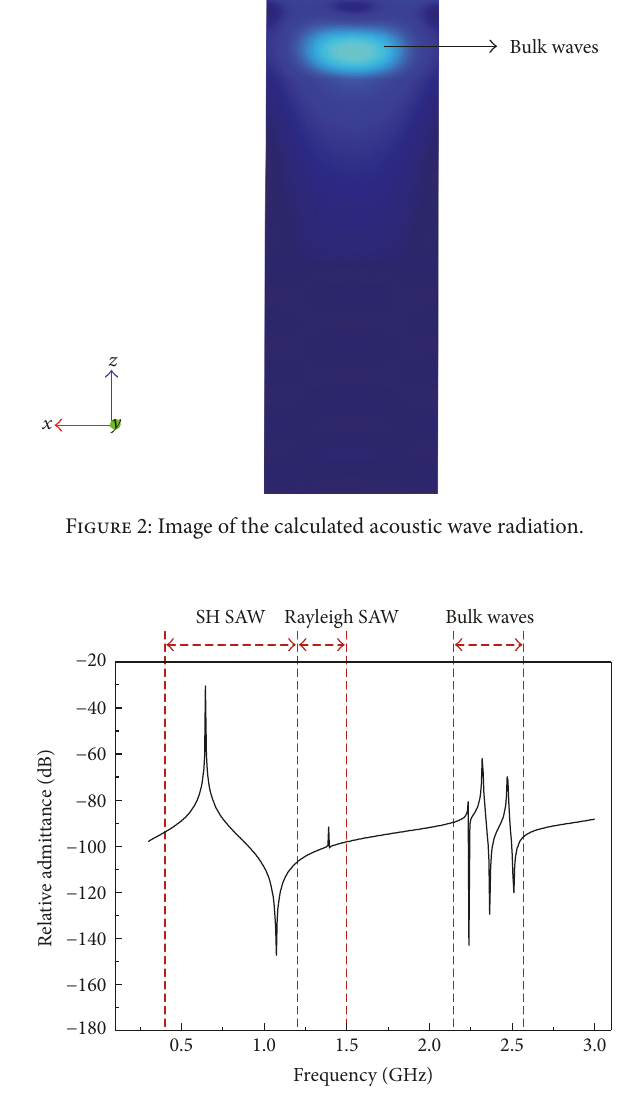
Figure3:Calculatedrelativeadmittance 𝑌(𝑓) ofinfinitelylongIDTs on layered structure as a function of frequency when ℎ PIMNT = 0.3𝜆